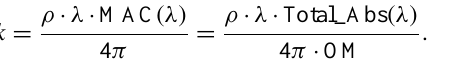
shell refractive index was set at 1.55–0.00156 i at 365 nm,